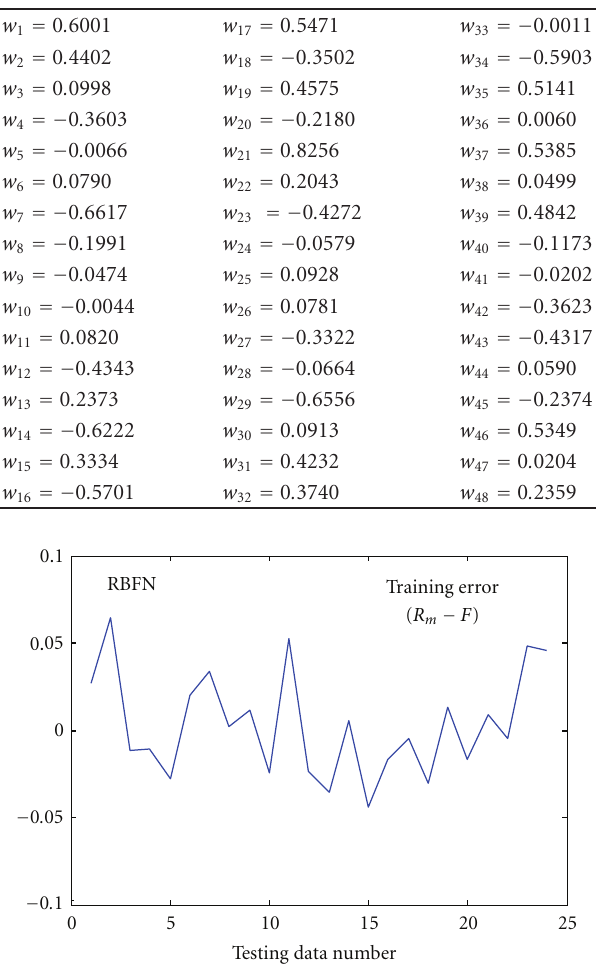
Table 7: Values of the members of the weight vector.